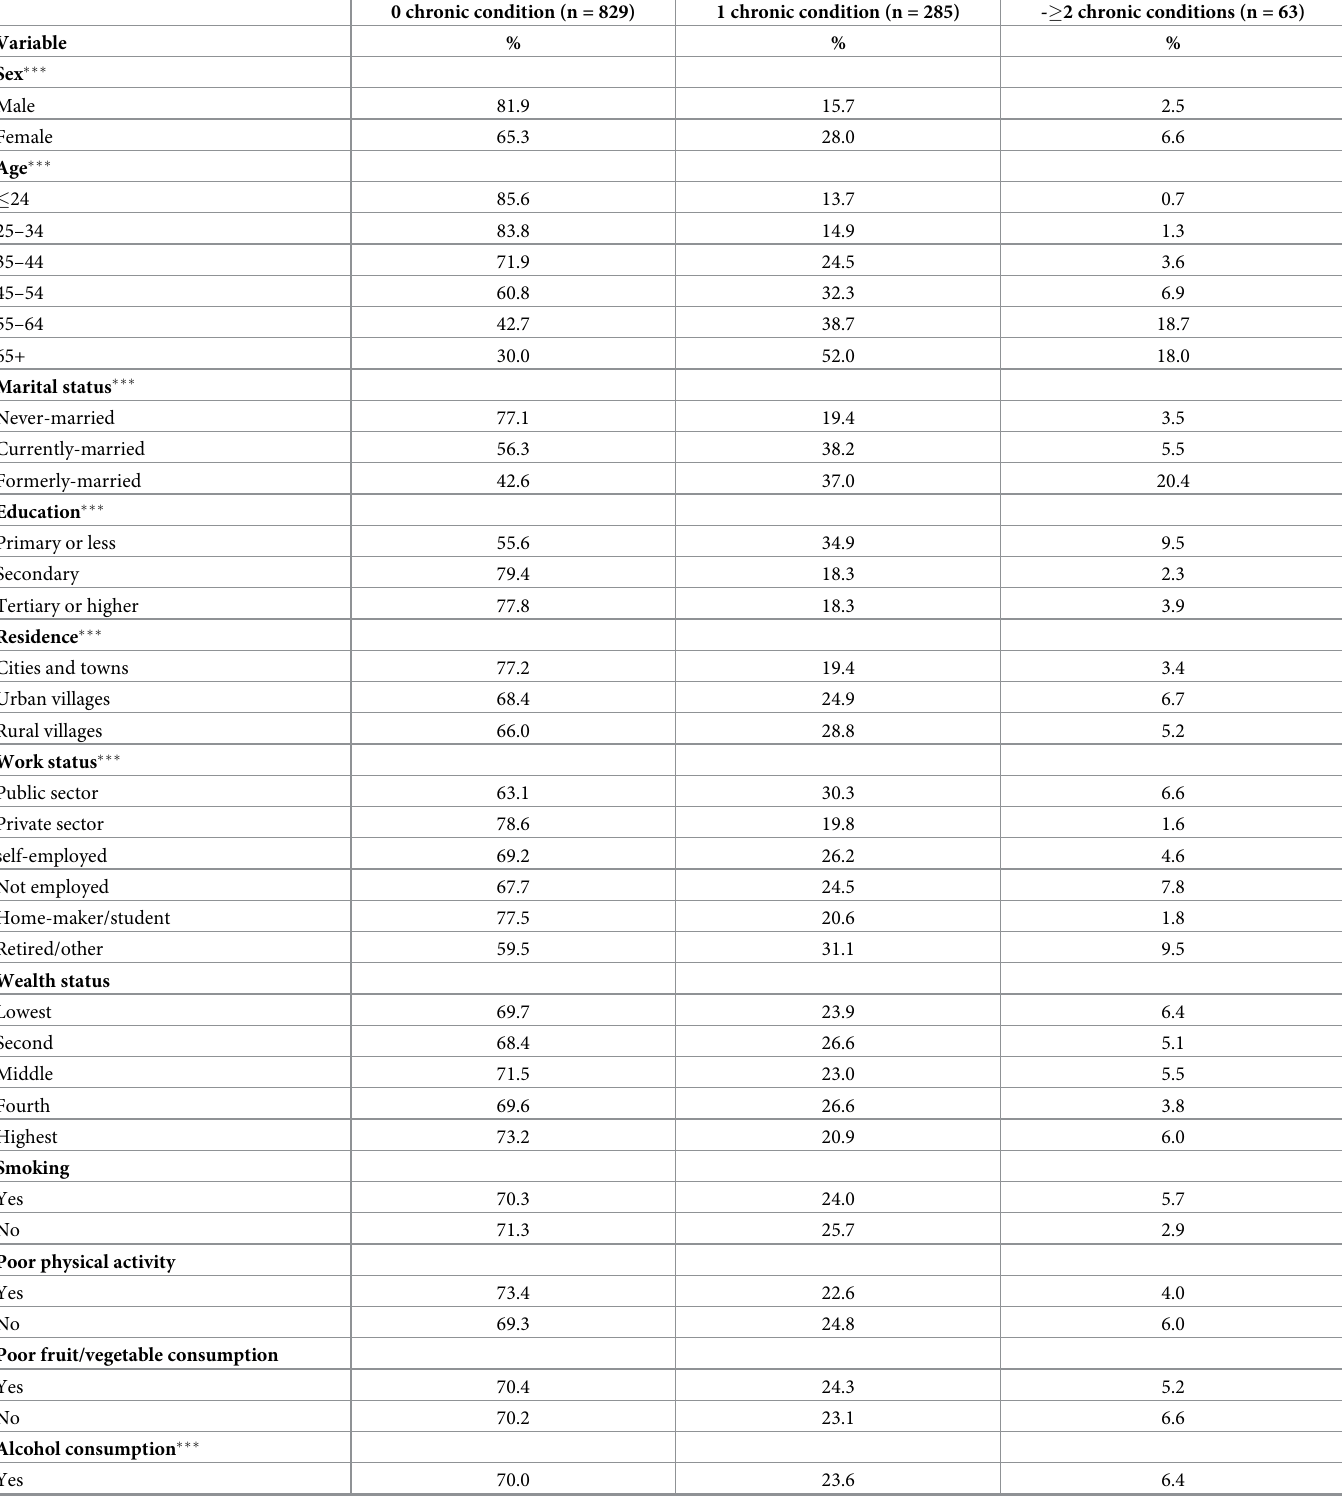
Table 2. Prevalence of number of chronic NCD conditions by socioeconomic and behavioural characteristics of the study